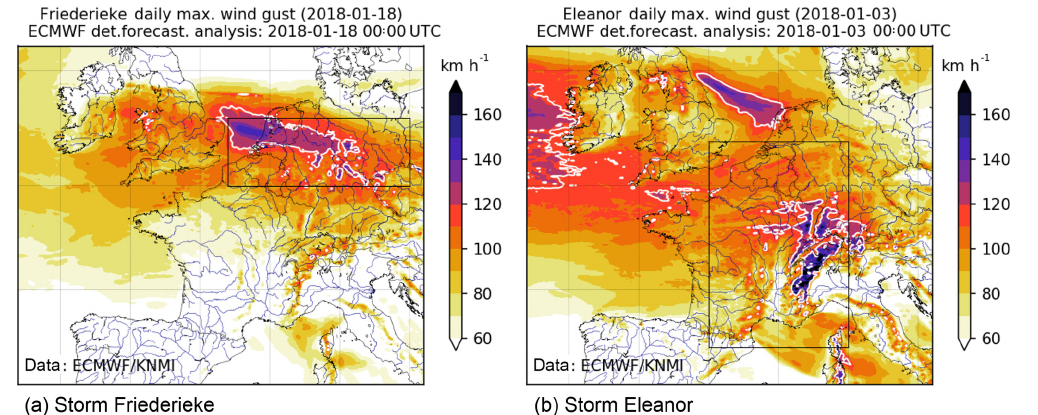
Figure 1. Strongest wind gusts during the storms Friederike (a) and Eleanor (b) as estimated from the ECMWF deterministic forecasts starting at 18 January 2018 00:00UTC and 3 January 2018 00:00UTC respectively. White contours are used to indicate areas where gusts exceed 118kmh − 1 . The boxes indicate the spatial event definitions (Sect.